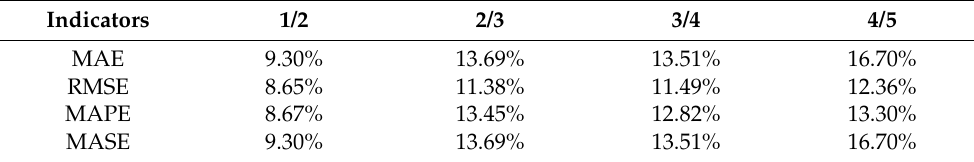
Table 4. Relative reduction of each indicator of MP-SAX-STM compared with STM of Set #4. Indicators 1/2 2/3 3/4 4/5